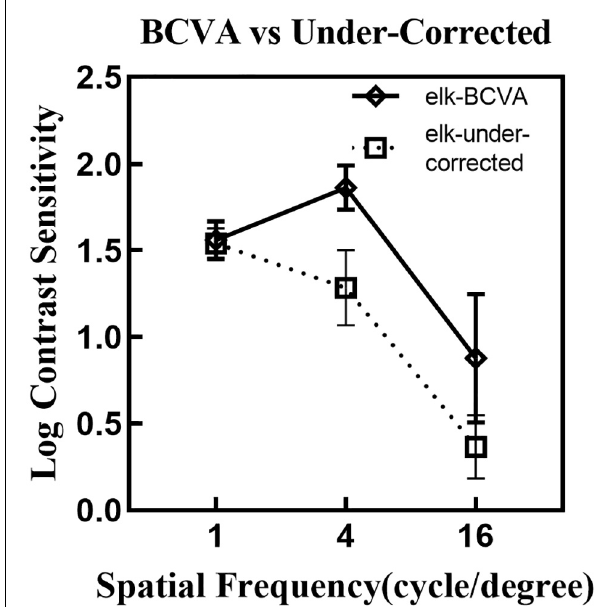
FIGURE 6 | A comparison of the mean logCS at different spatial frequencies under the BCVA (solid line) and under-corrected visual acuity (dotted line) using the eye tracking test. Error bars denote one standard deviation across spatial frequencies. LogCS was significantly reduced at medium and high spatial frequencies, while no distinct difference was noted for the low spatial frequency. BCVA, best-corrected visual acuity; elk, eye tracking